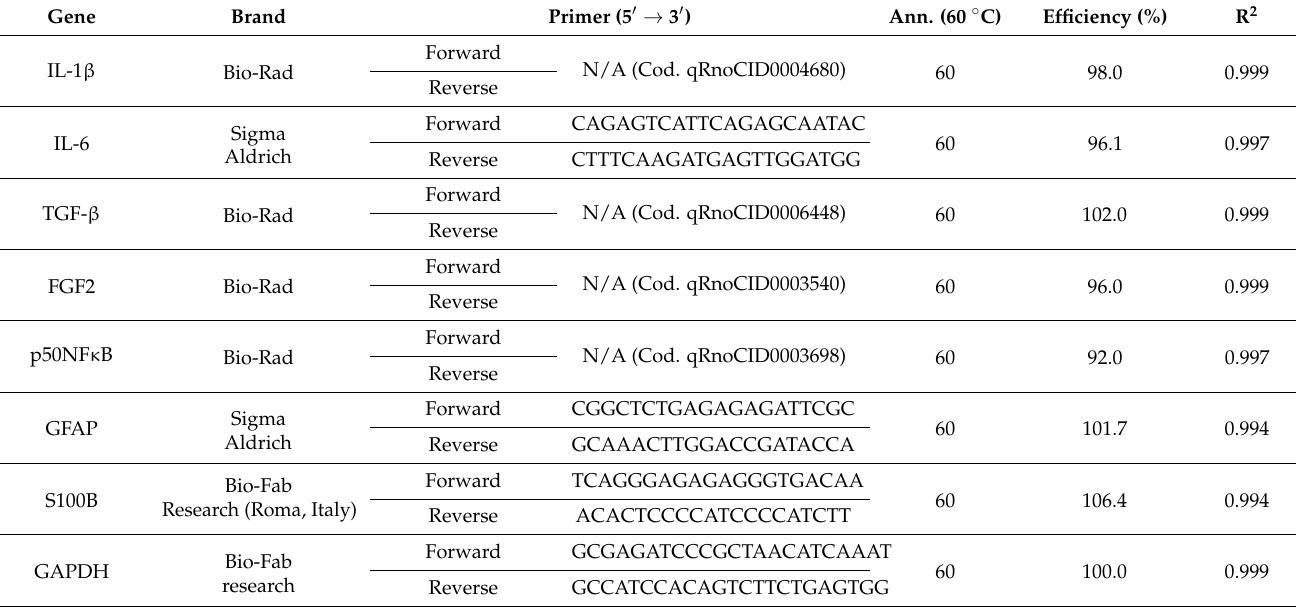
Table 2. RT-qPCR parameters and list of